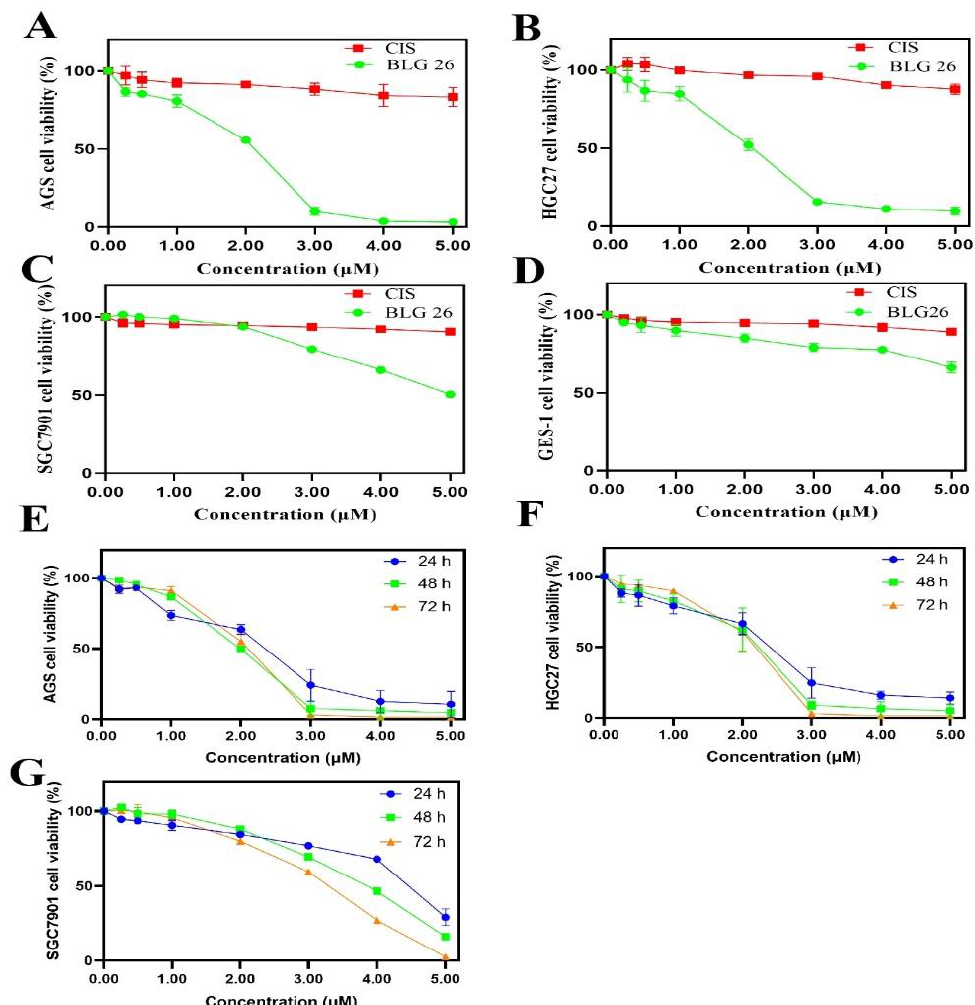
Figure 1. Concentration- and time-dependent effects of BLG26 on HGC27, SGC7901, AGS, and GES-1. ( A – D ) The effects of BLG26 and CIS at the concentration of 0.25, 0.50, 1.00, 2.00, 3.00, 4.00, 5.00 µ M on the growth of human gastric cell lines AGS, HGC27, SGC7901, and human normal gastric epithelial cell line GES-1. DMSO was used as negative control and CIS was used as positive control. ( E – G ) Concentration- and time-dependent effects of BLG26 on AGS, HGC27, SGC7901. Values are shown as the means ± standard, n = 3. compared with